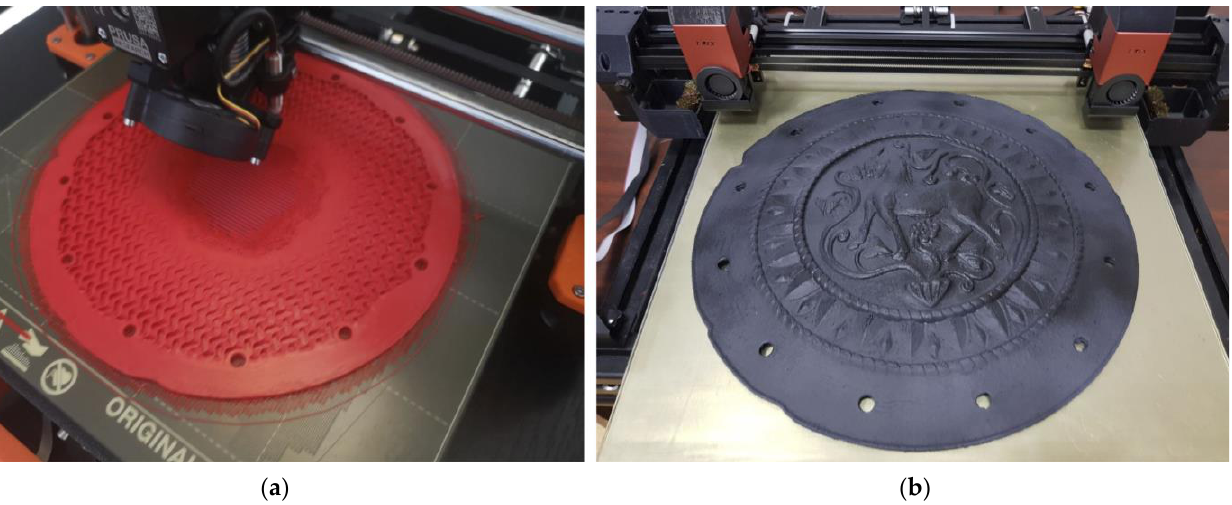
Figure 28. 3D printed embossed disks that will enable 3D model tracking. ( a ) Scaled down disk printed on a Prusa MK3S+ 3D printer; ( b ) True scale printed disk printed on a FORMBOT T-Rex 3.0 3D printer.